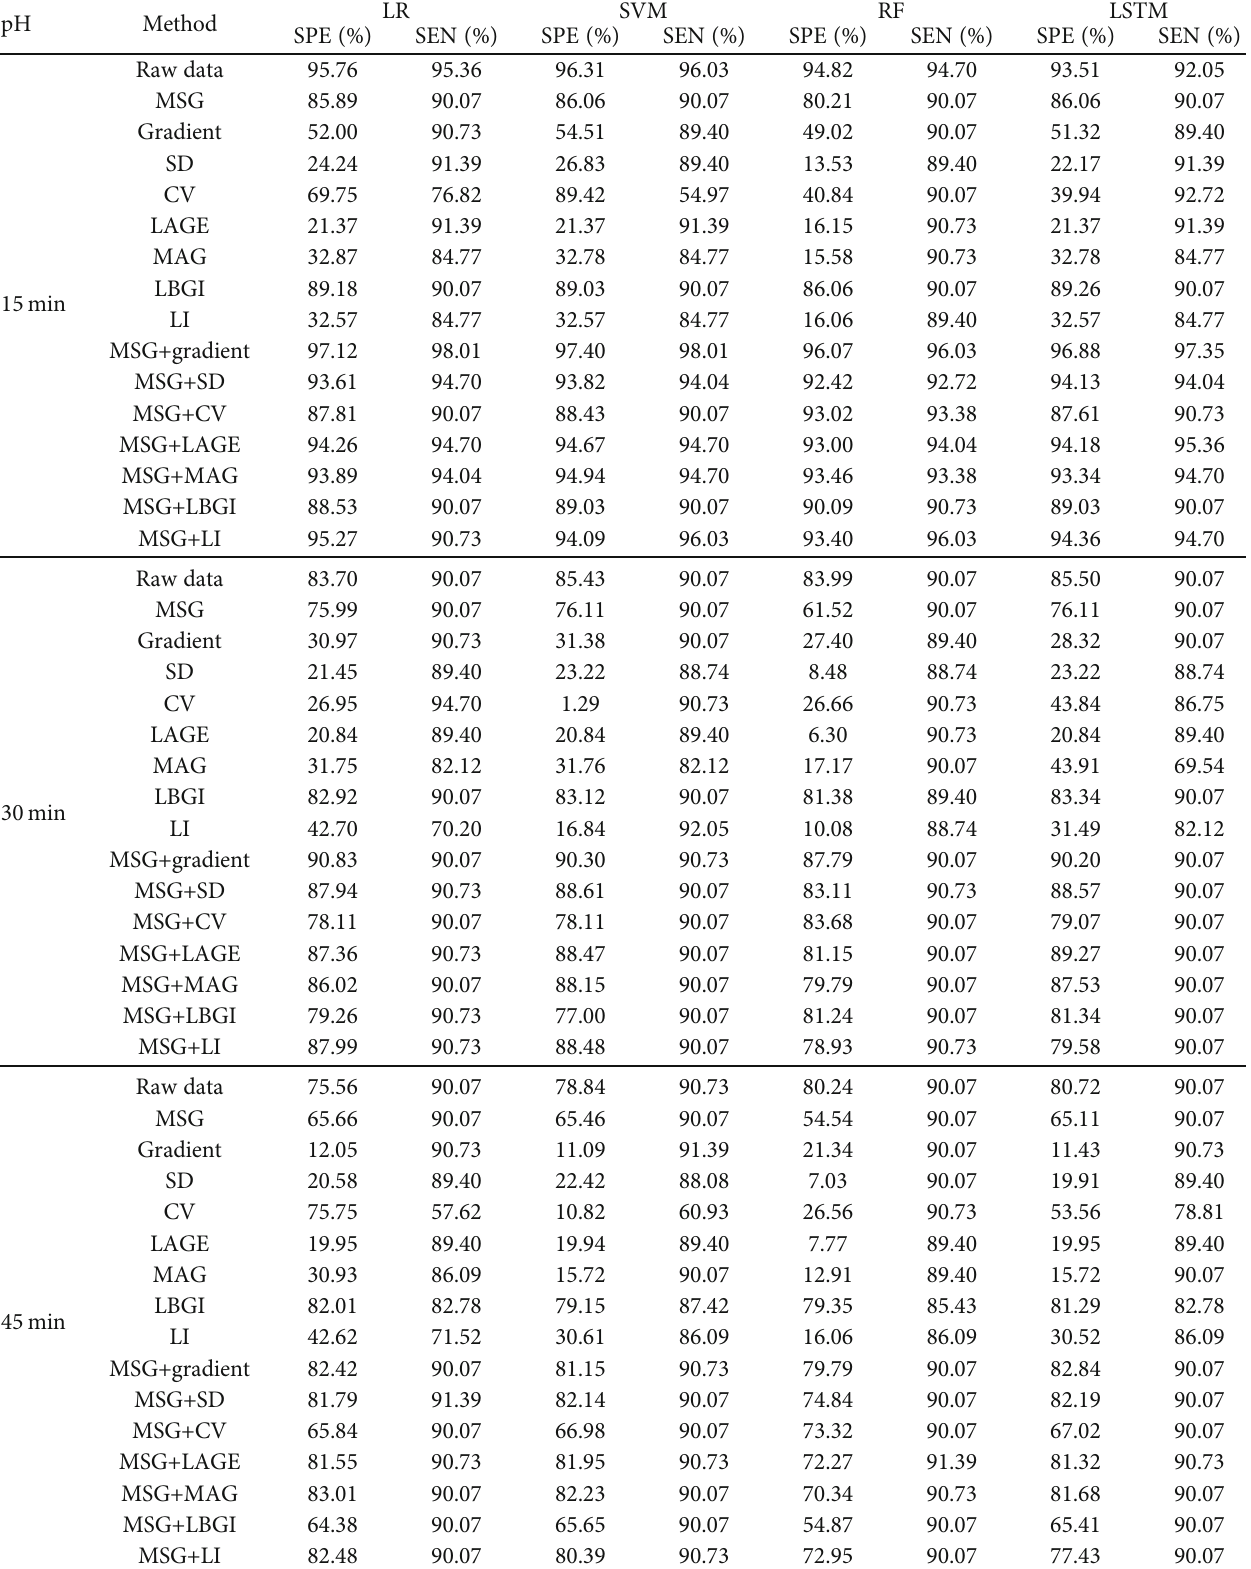
Table 1: The speci fi city and sensitivity of the prediction of nocturnal hypoglycemic events based on di ff erent metrics and algorithms (CGM length = 30 minutes